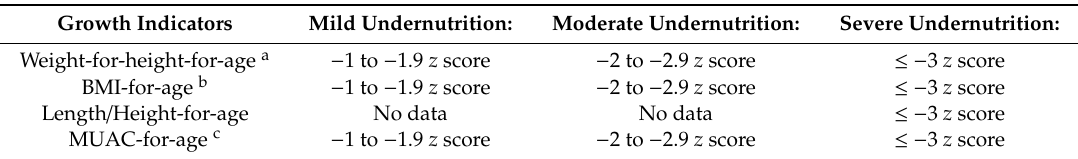
Table 1. Primary indicators of the severity of undernutrition-based z -scores from a single data point (modified from Becker et al.